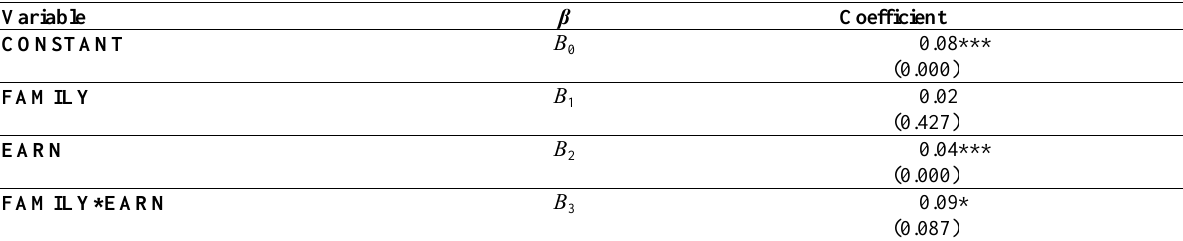
Table 2: Regression results for stock returns on